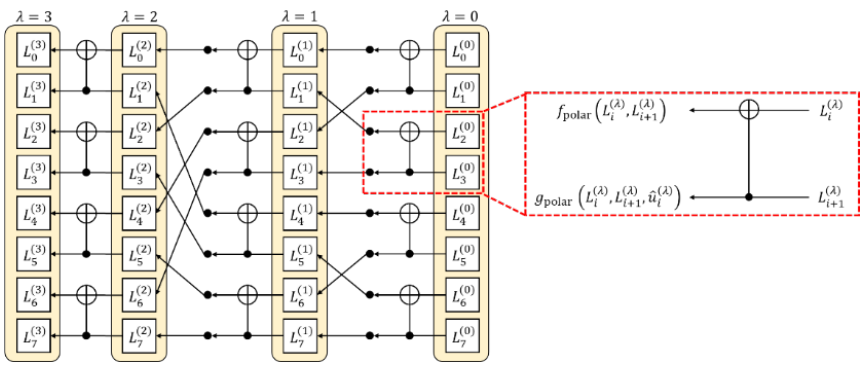
Figure 9. Schematic diagram of SCLD algorithm for N = 2 3 .